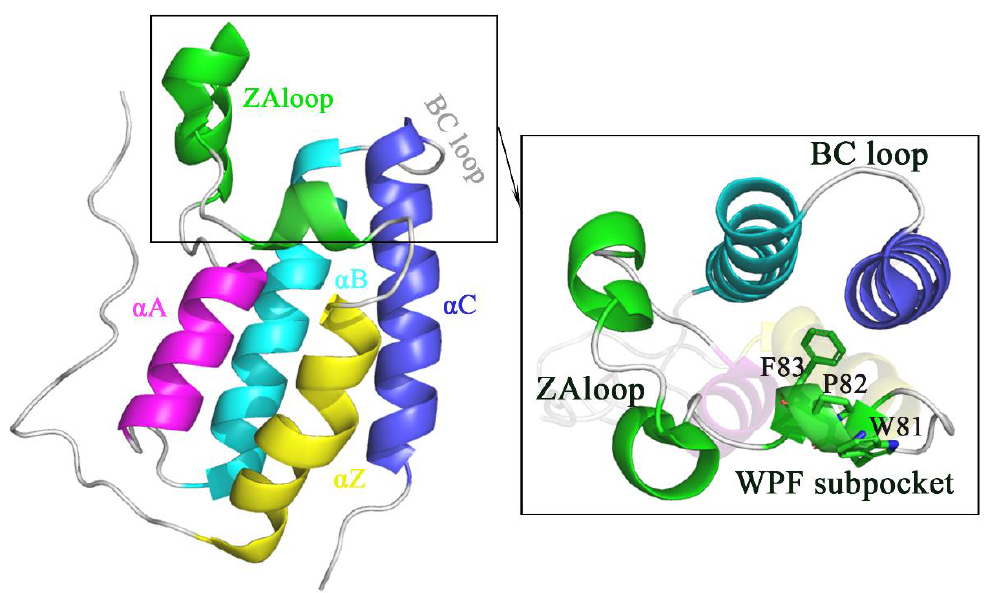
Figure 1. The structure of BRD4 protein and the binding pocket of BRD4.